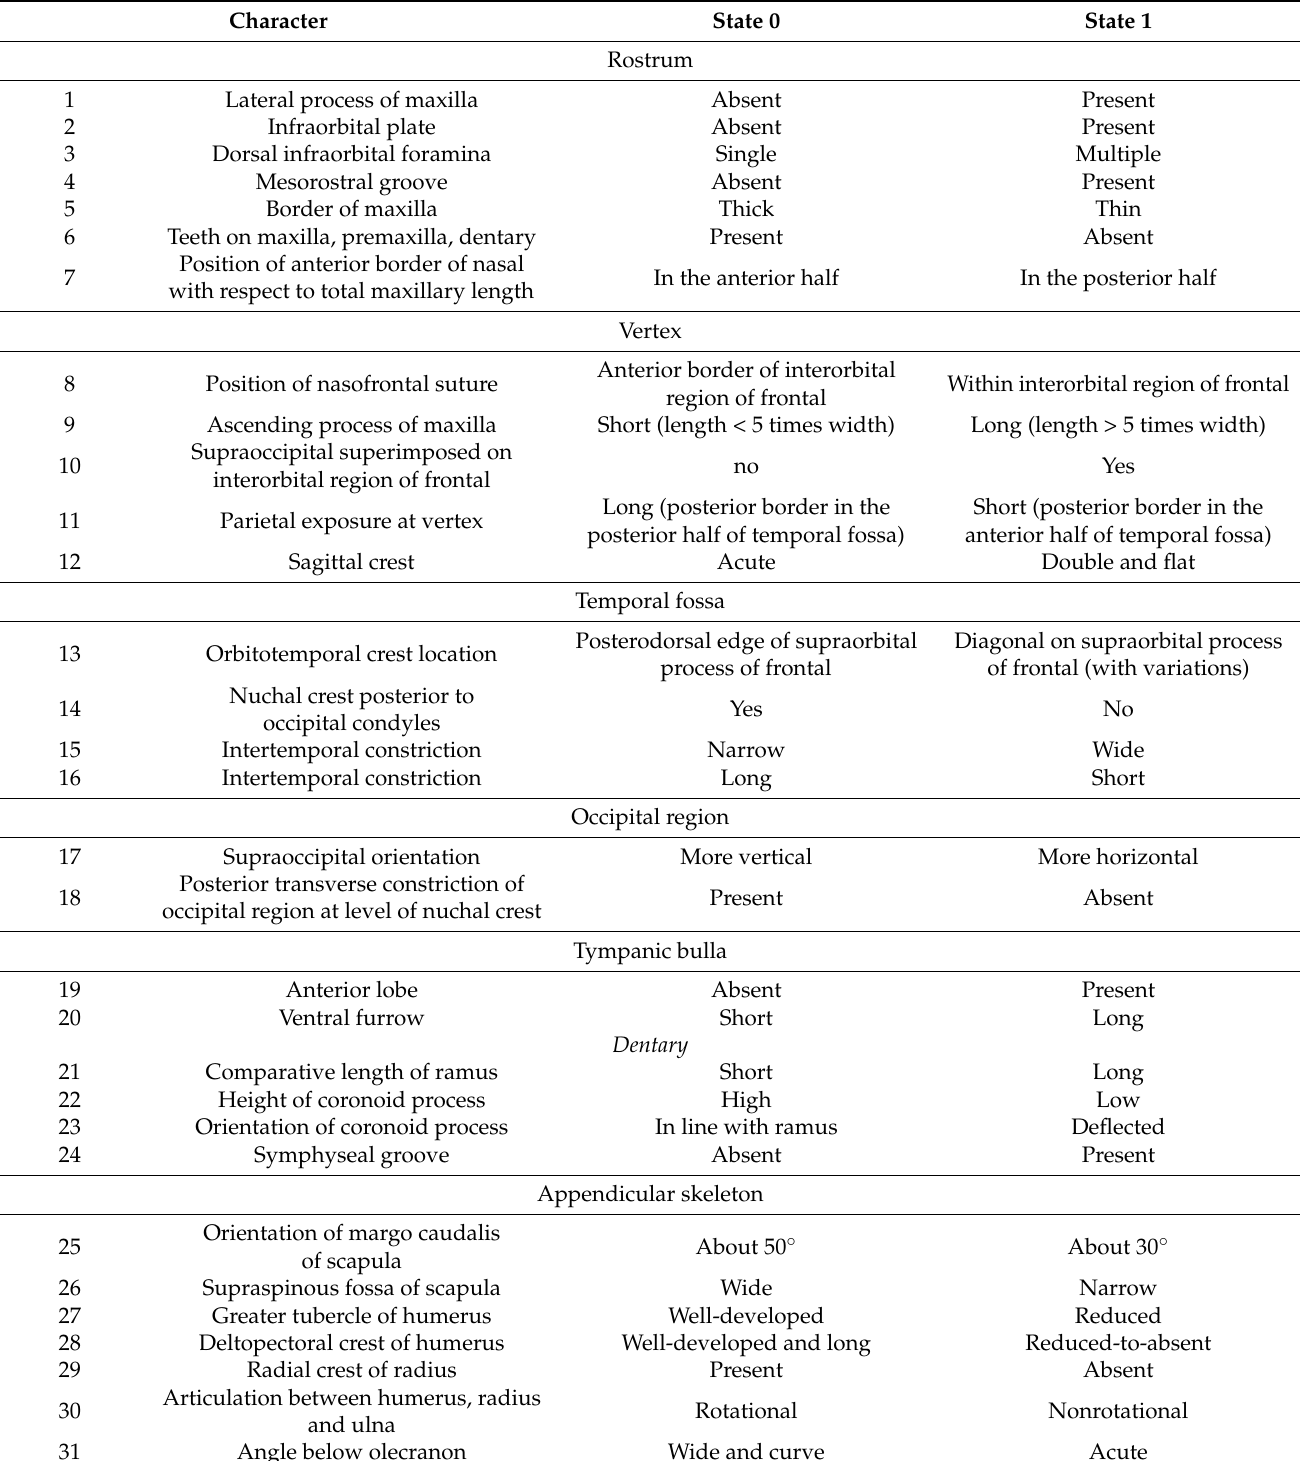
Table 2. Character states used in the analysis of character